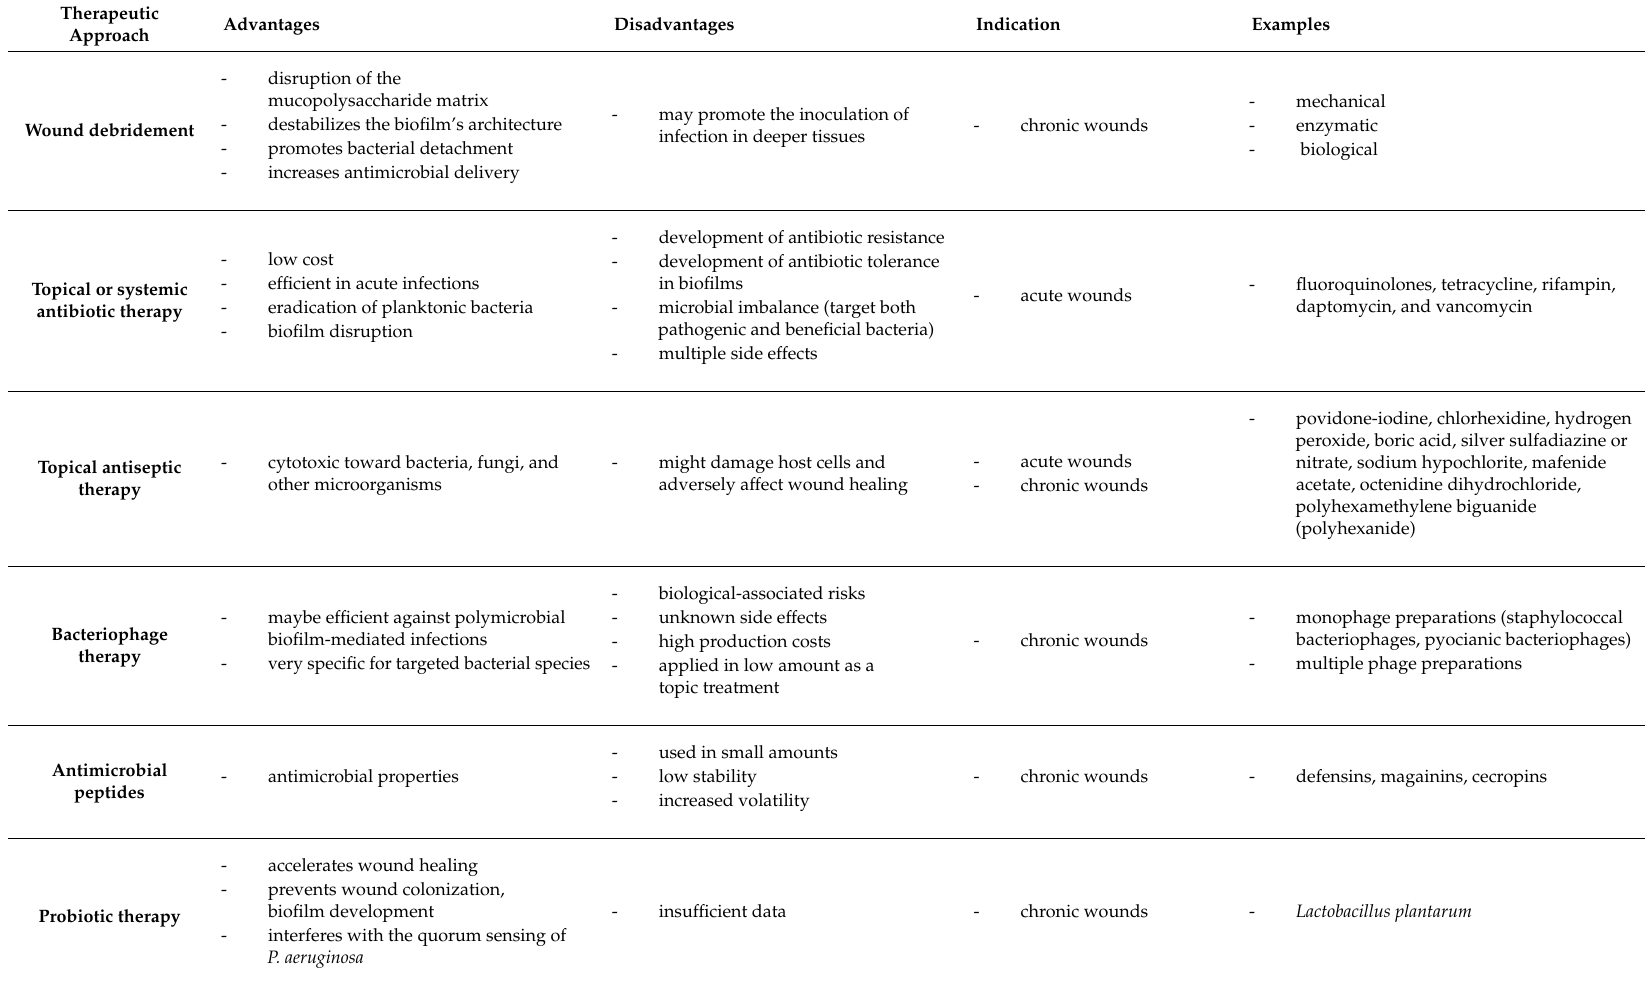
Table 1. Wound therapy